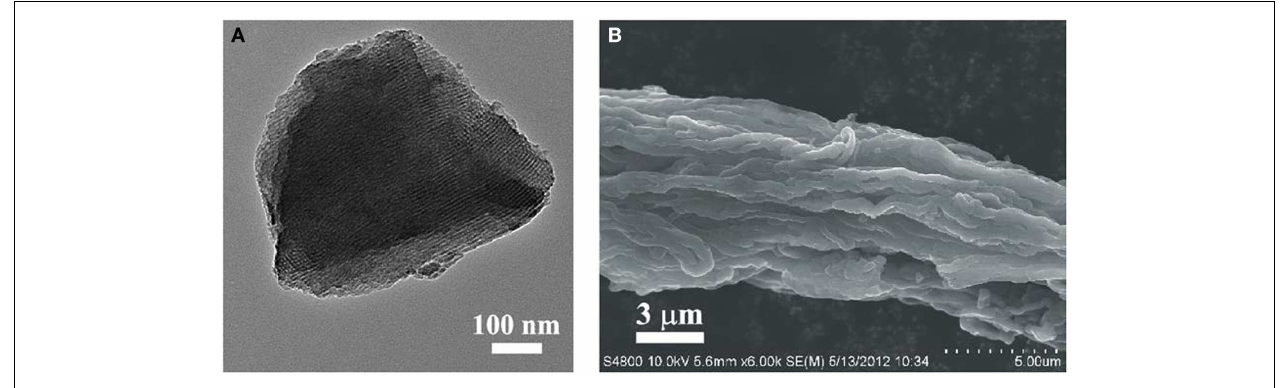
FIGURE 1 | (A) TEM image and (B) SEM image of